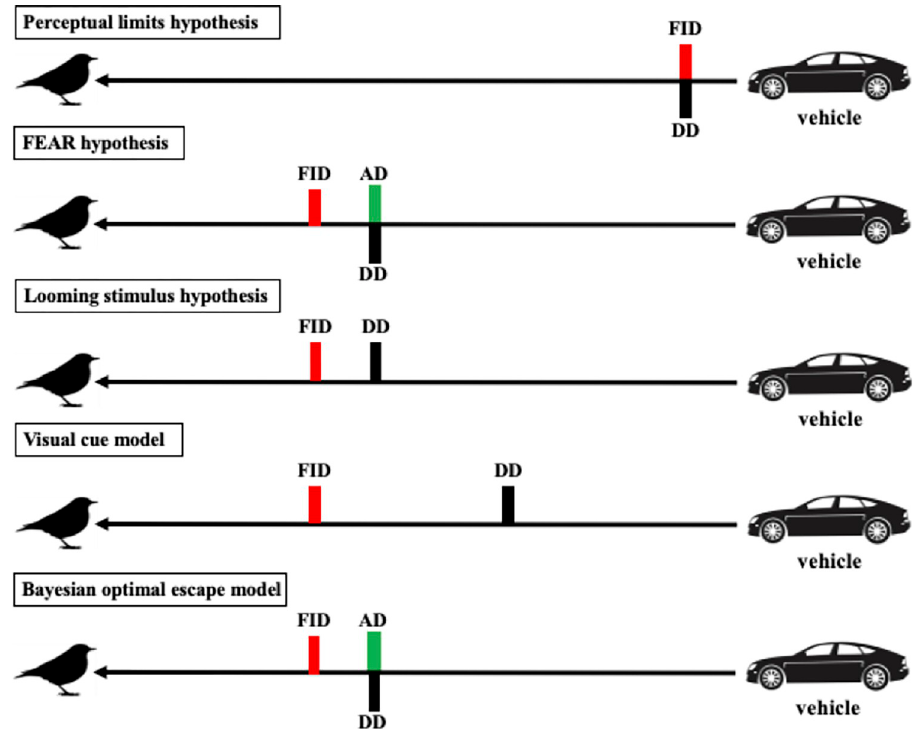
Fig 5. Illustrated differences in the detection assumptions for the five models capable of producing quantitative predictions. FID refers to flight initiation distance, AD refers to alert distances, and DD refers to detection distance.